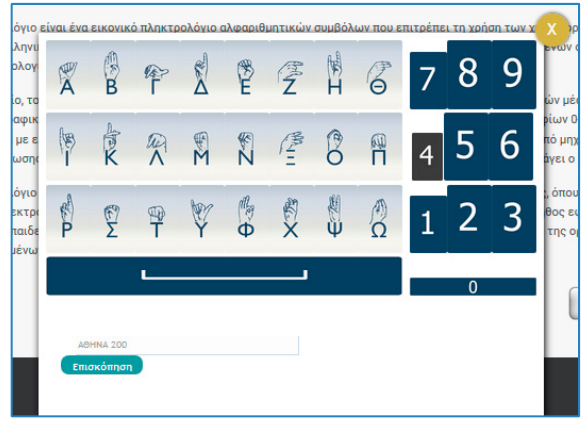
Figure 11. Fingerspelling keyboard service.